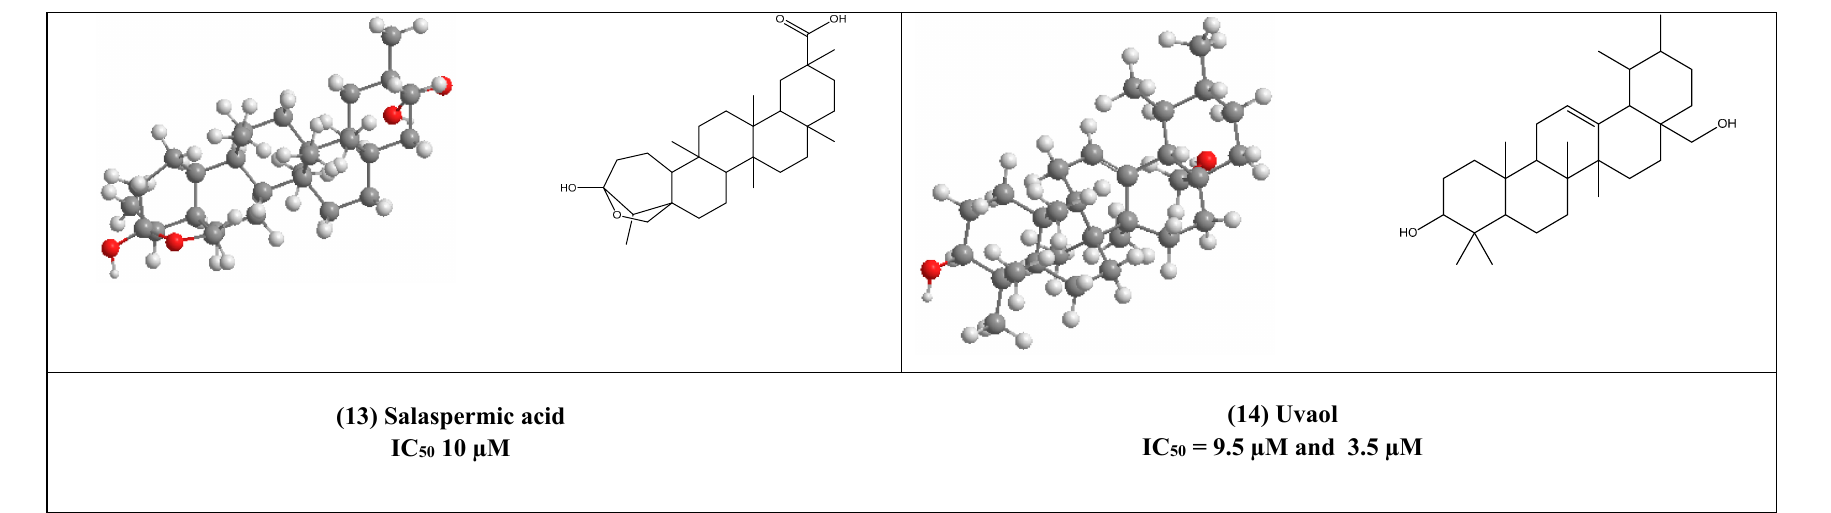
Figure 3. The 2D and 3D chemical structures of virus reverse transcriptase inhibitors.